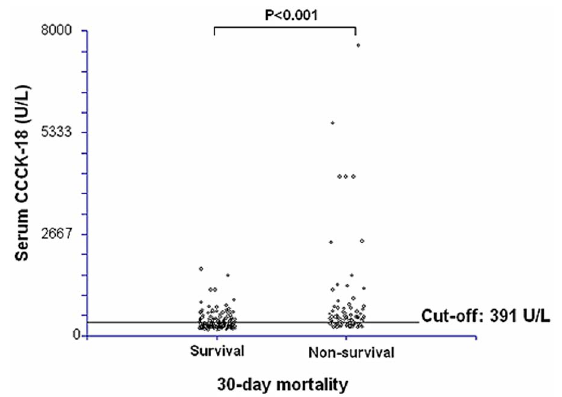
Figure 3. Dot-plot of serum caspase-cleaved citokeratin (CCCK)-18 levels in 30-day surviving and non-surviving septic patients.